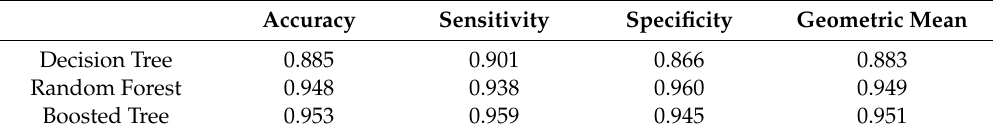
Table 4. Performance measures for classification of parallel turns on test data set.